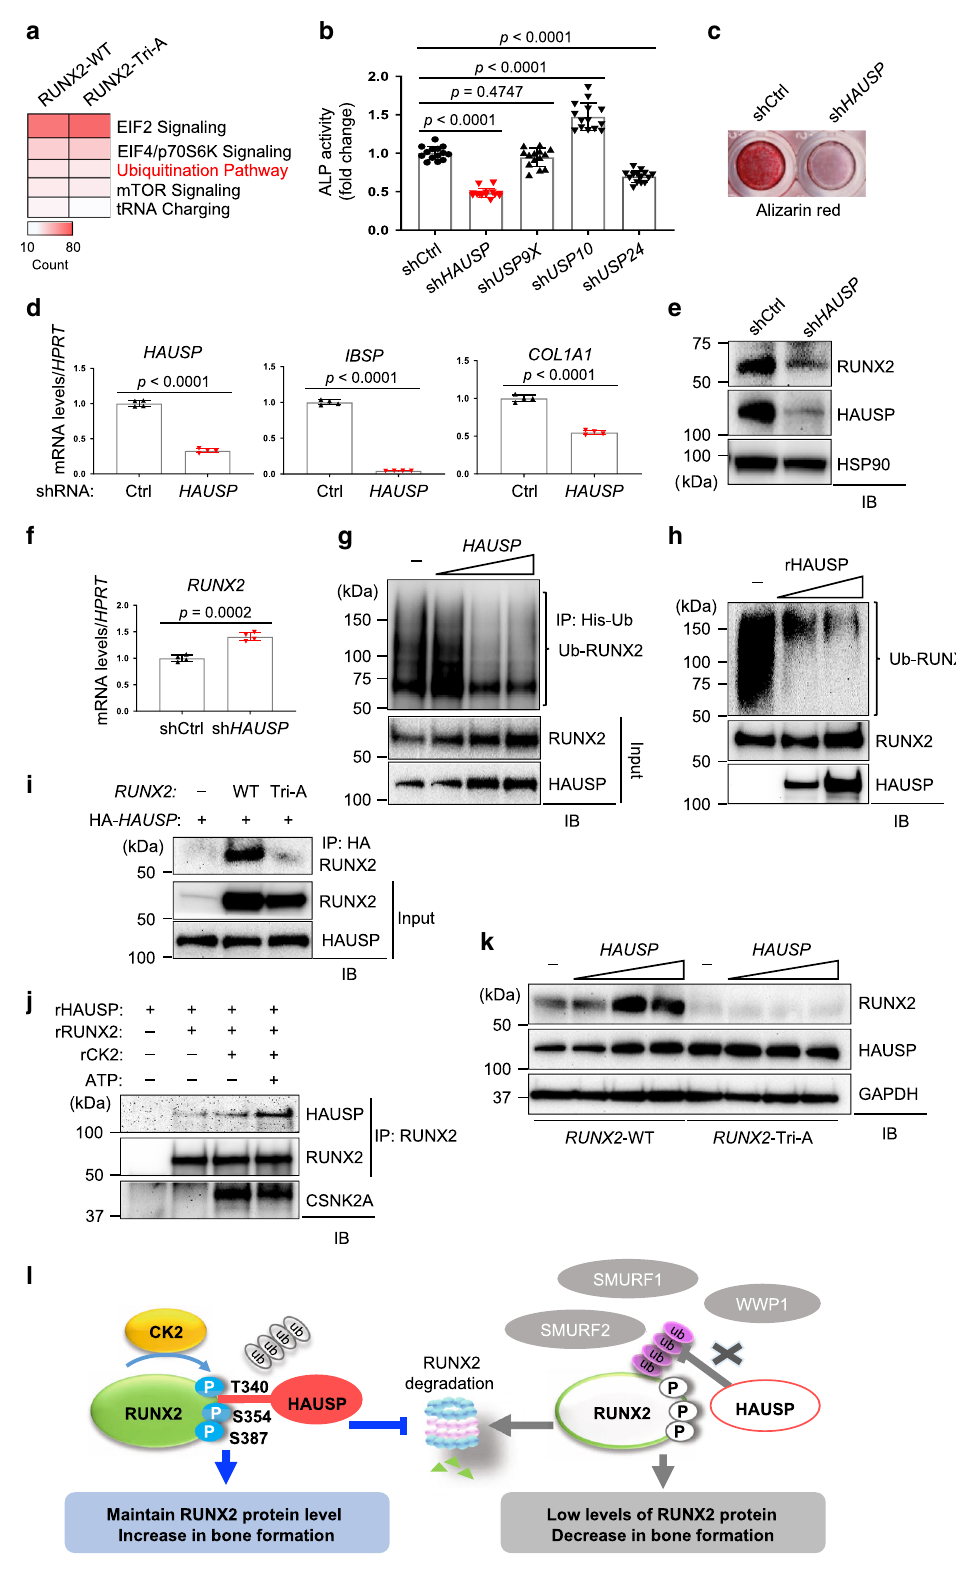
MicroCT, radiography, and skeletal preparation . MicroCT was used for quali- tative and quantitative assessment of trabecular and cortical bone micro- architecture and performed by an investigator blinded to the genotypes of the animals under analysis. Femurs excised from the indicated mice were scanned using a microCT 35 (Scanco Medical) with a spatial resolution of 7 μ m. For tra- becular bone analysis of the distal femur, an upper 2.1mm region beginning